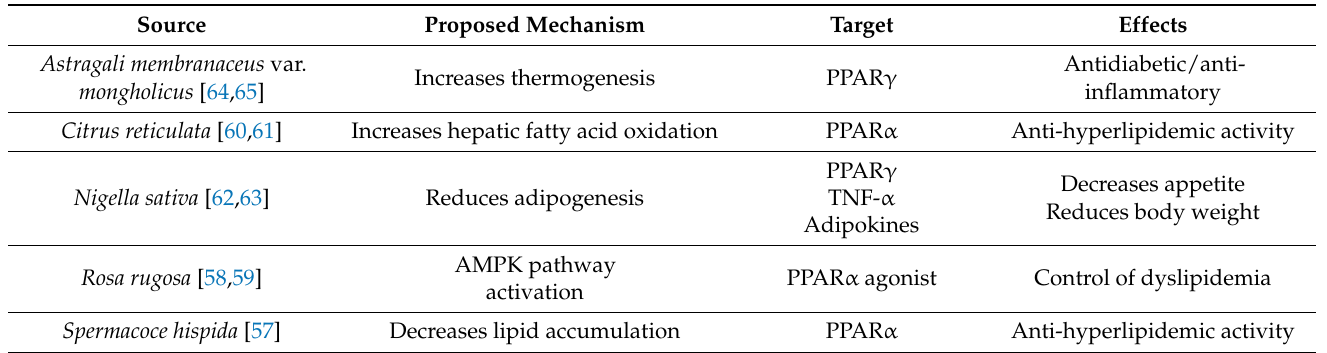
Table 3. Herbs containing nutraceuticals acting on PPAR